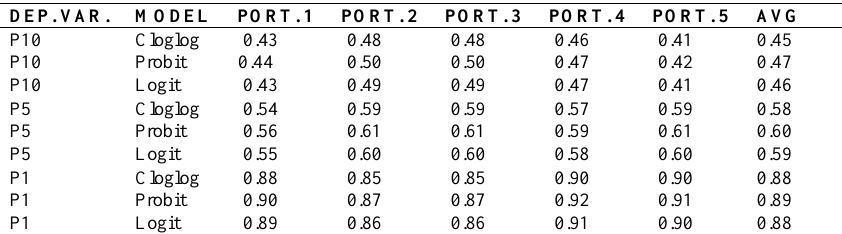
Table 12. Results for the Gini coefficient analysis for the portfolios. In-sample analysis DEP. VAR.